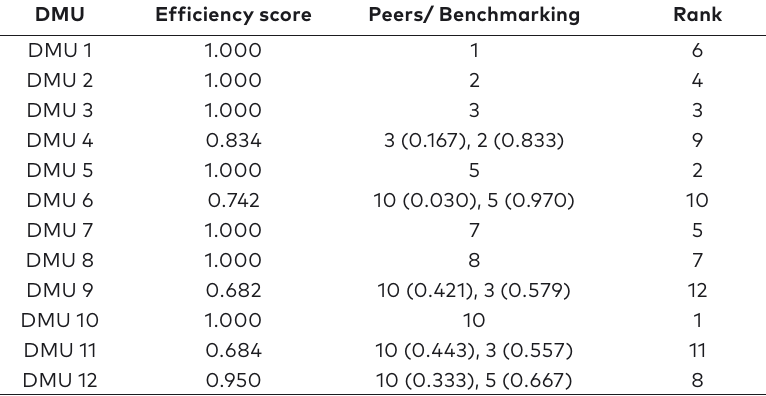
Table 5. Results of DEA for Framework